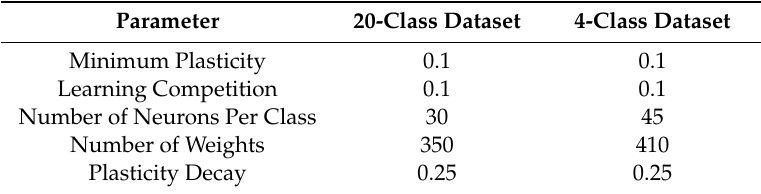
Table 1. Key parameters and their optimized values for the SNN for the 20-class and 4-class